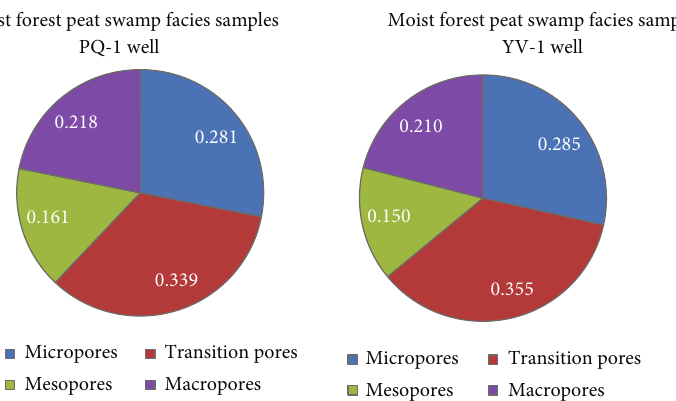
Figure 11: Average pore size proportion of moist forest swamp facies samples from PQ-1 and YV-1